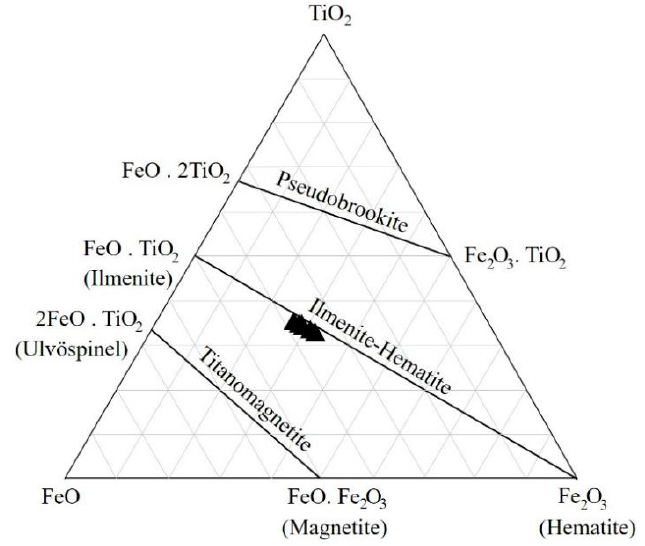
Figure 10. Ternary FeO–Fe 2 O 3 –TiO 2 diagram and plots of ilmenite–hematite inclusions in sapphire from Southern Vietnam. The diagram was suggested by Buddington and Lindsley [1].